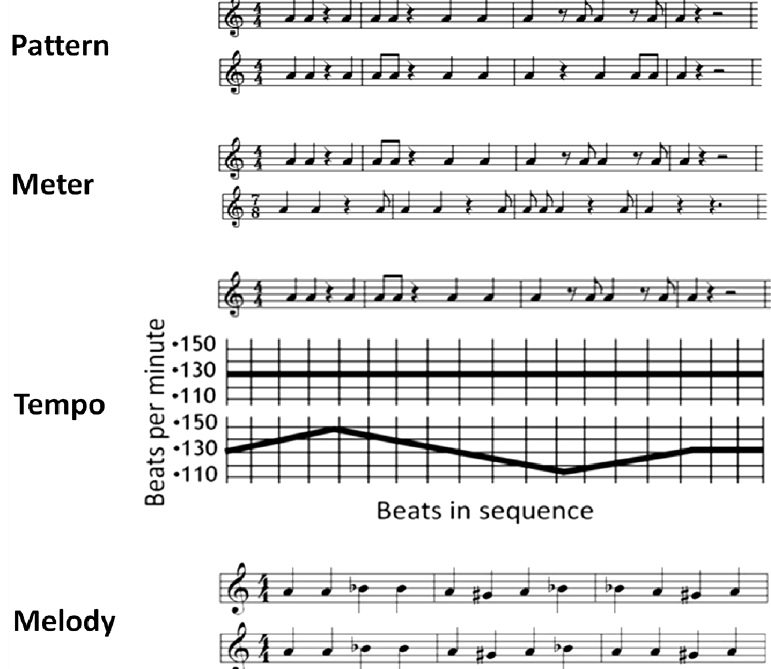
Figure 1. From top to bottom: a sample of a pair of stimuli for a trial in the Pattern task in which there are different patterns; a sample of a pair of stimuli for a trial in the Meter task in which there are different meters; a sample of a pair of stimuli for a trial in the Tempo task in which there are different tempos; and a sample of a pair of stimuli for a trial in the Melody